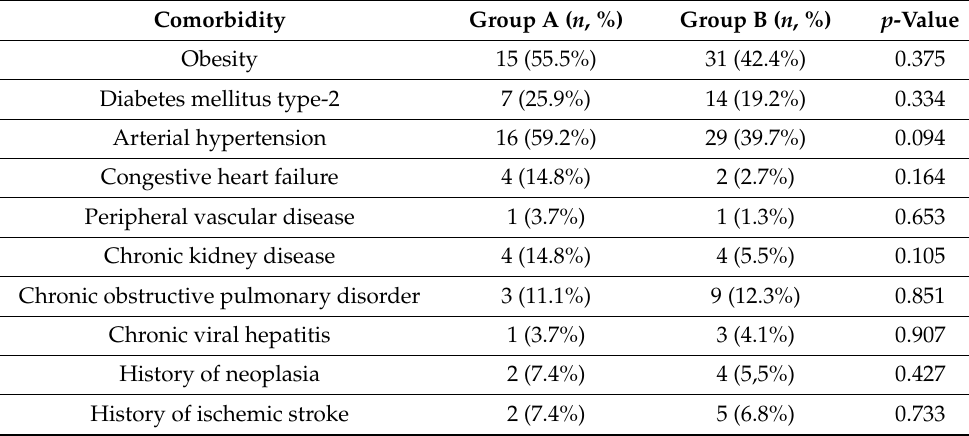
Table 1. Comorbidities in SARS-CoV-2 patients with and without pericardial effusion.